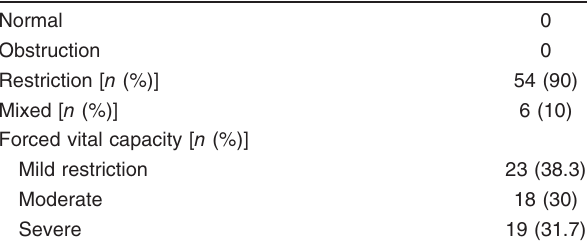
Table 7 Illustrate the degree of restriction by spirometery among cases Normal